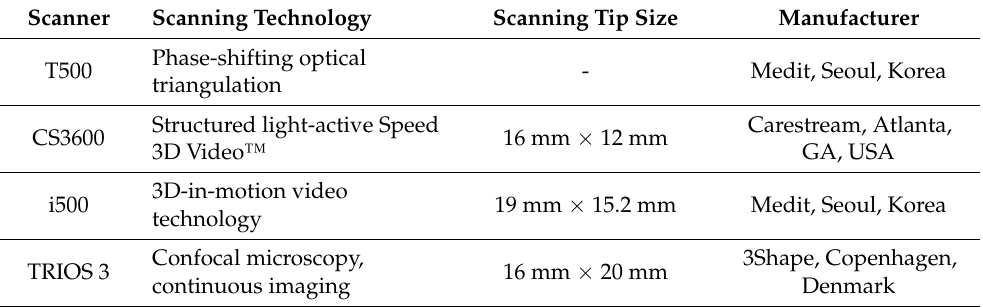
Table 1. Scanners used in the study.